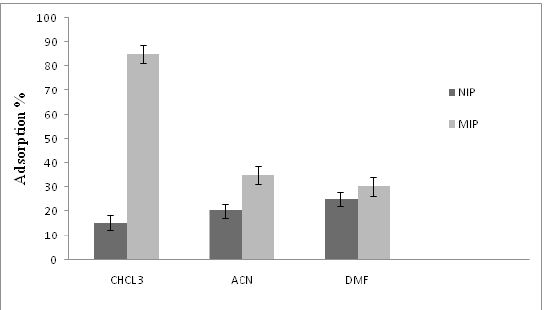
Figure 5. Scanning electron micrographs: (A) unleached MIP; (B) leached MIP; (C) leached NIP.